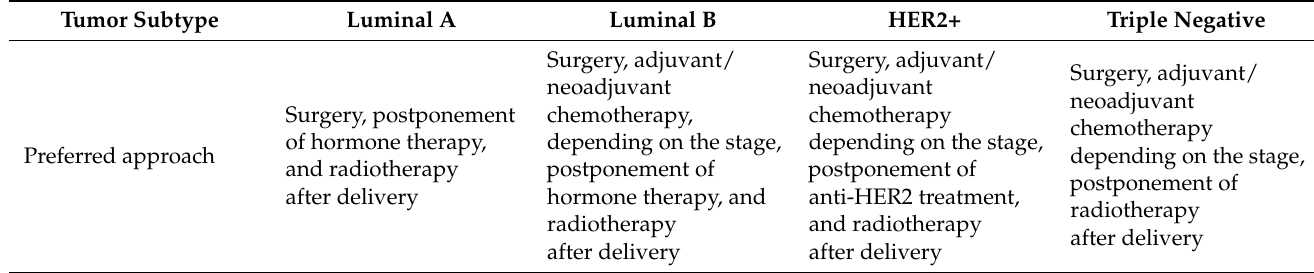
Table 1. Tailoring treatment according to the type of breast